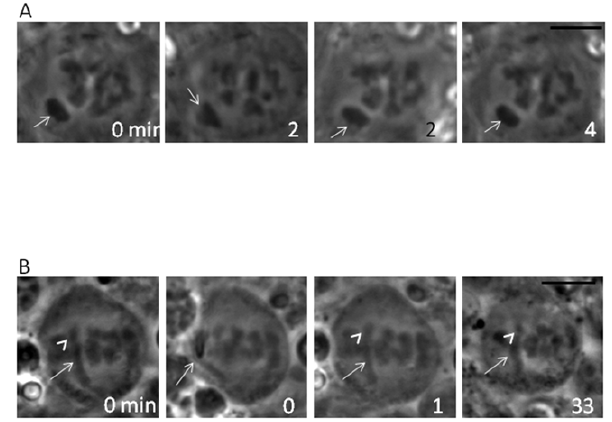
Figure 3. Micromanipulation of primary spermatocytes in Physocyclusmexicanus and Holocnemuspluchei . A. In a Physocyclus mexicanus metaphase I spermatocyte (0 min.), a small micromanipula- tion needle was used to pull on the univalent chromosome near the spindle pole (2–4 min.), showing a single X chromosome (arrow). Bar=10 m m. B. In a Holocnemus pluchei metaphase I spermatocyte (0 min.), a small micromanipulation needle was used to pull on the sex chromosomes in the middle of the spindle (0 min., arrow). Following the pulling, the chromosomes immediately return to their original position (1, 33 min.), indicating that chromosomes are connected to the spindle at both ends. X chromosome indicated by arrow, Y chromosome by arrowhead. Bar=10 m